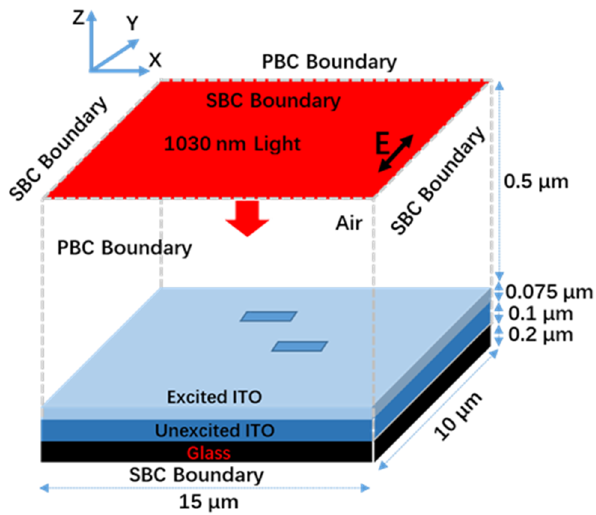
Figure 5. Schematic of the simulation setup with COMSOL Multiphysics software. The arrow E shows the laser polarization.